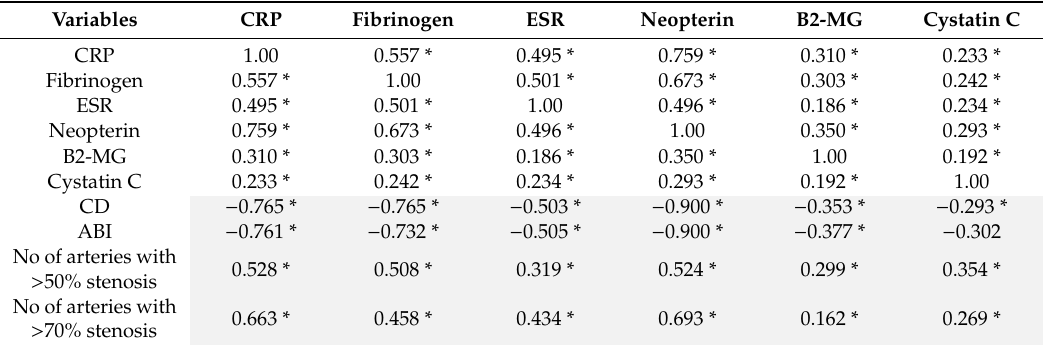
Table 3. Correlations between CD, ABI, the number of arteries with significant stenosis ( > 50% and > 70%) and